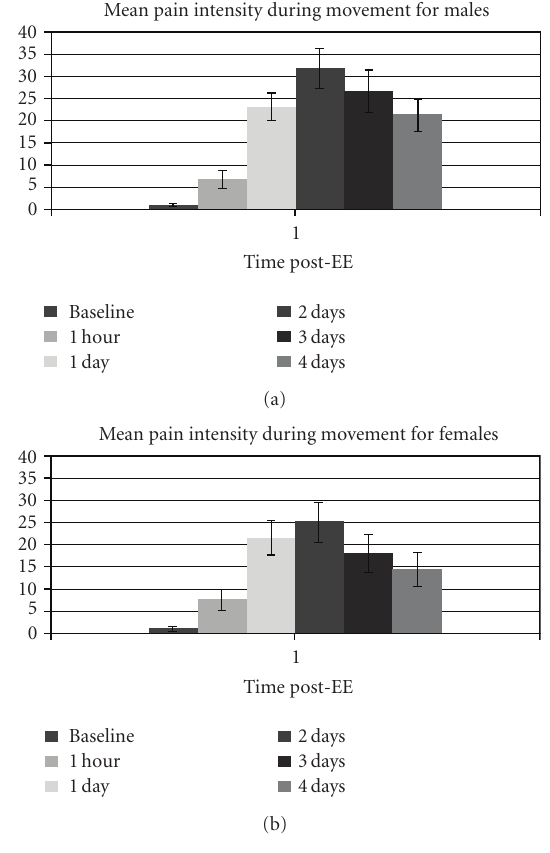
Figure 1: Progress of pain intensity throughout the study period. Mean ( ± SE) of pain intensity ratings (scale 0–100) during unloaded movement through full range of motion of the elbow. Time after EE refers to time elapsed after the eccentric exercise protocol, during which muscle damage was induced. Pain intensity rating was one of two distinct pain outcomes. The other, pain unpleasantness rating, followed a similar pattern following the eccentric exercise protocol. Males: N = 26 (baseline), N = 27 (all other times); females: N = 20 (4 days), N = 21 (all other times).